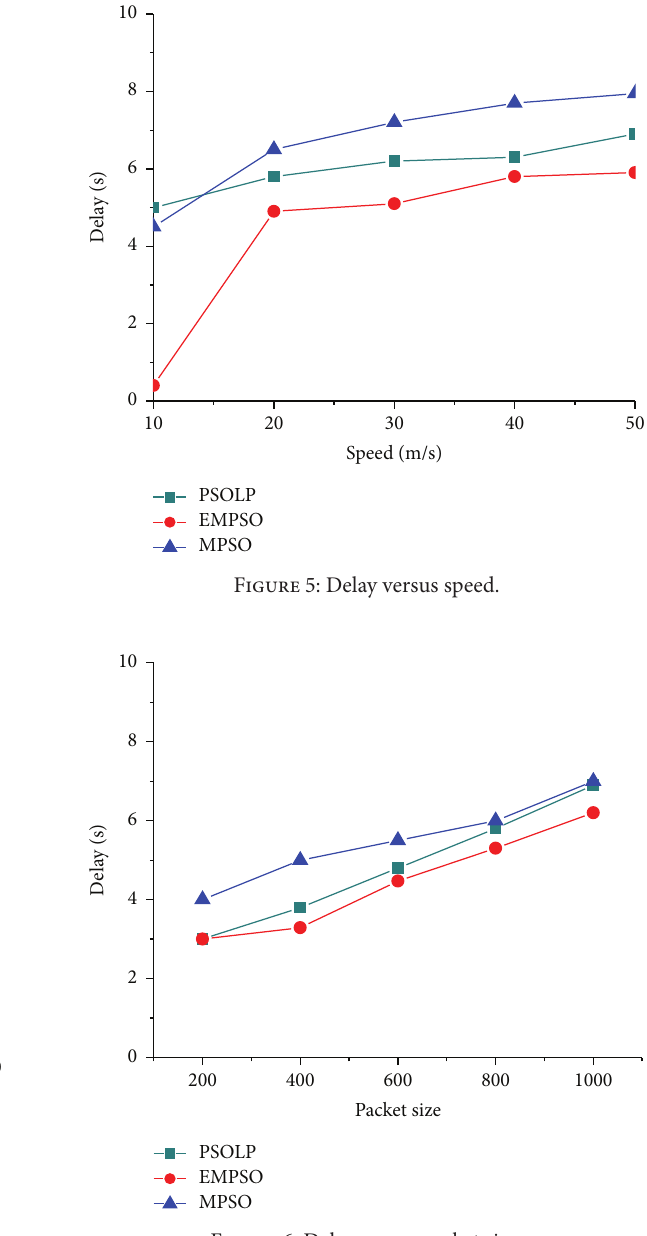
Figure 6: Delay versus packet